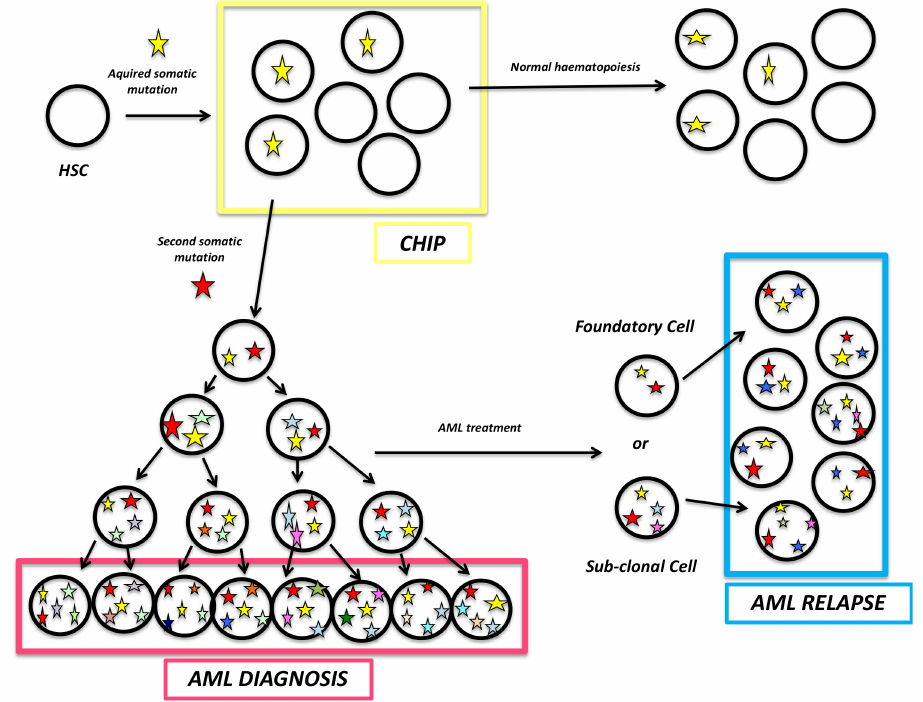
Figure 3. Leukemogenesis and AML clonal evolution: from preleukemic state to relapse. HSC: Hematopoietic Stem Cell; CHIP: Clonal Haematopoiesis of Indeterminate Potential; AML: Acute Myeloid